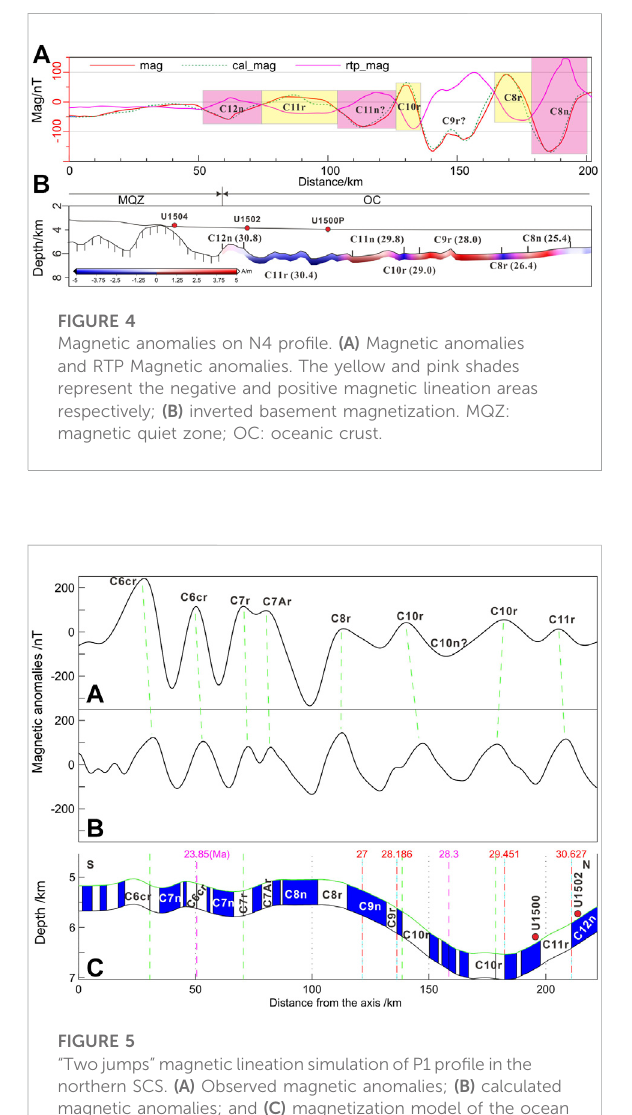
FIGURE 5 “ Twojumps ” magneticlineationsimulationofP1pro fi leinthe northern SCS. (A) Observed magnetic anomalies; (B) calculated magnetic anomalies; and (C) magnetization model of the ocean crust. The pink dotted lines represent the jump positions of the spreading centre.